Question: Author a descriptive caption for the visualization shown.
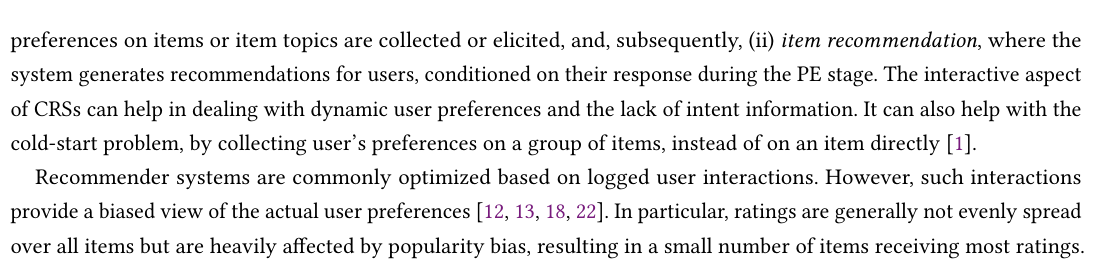
Answer: Rating distribution over item topics on the Coat Music dataset (Left), and Genre popularity in the MovieLens dataset (Right).